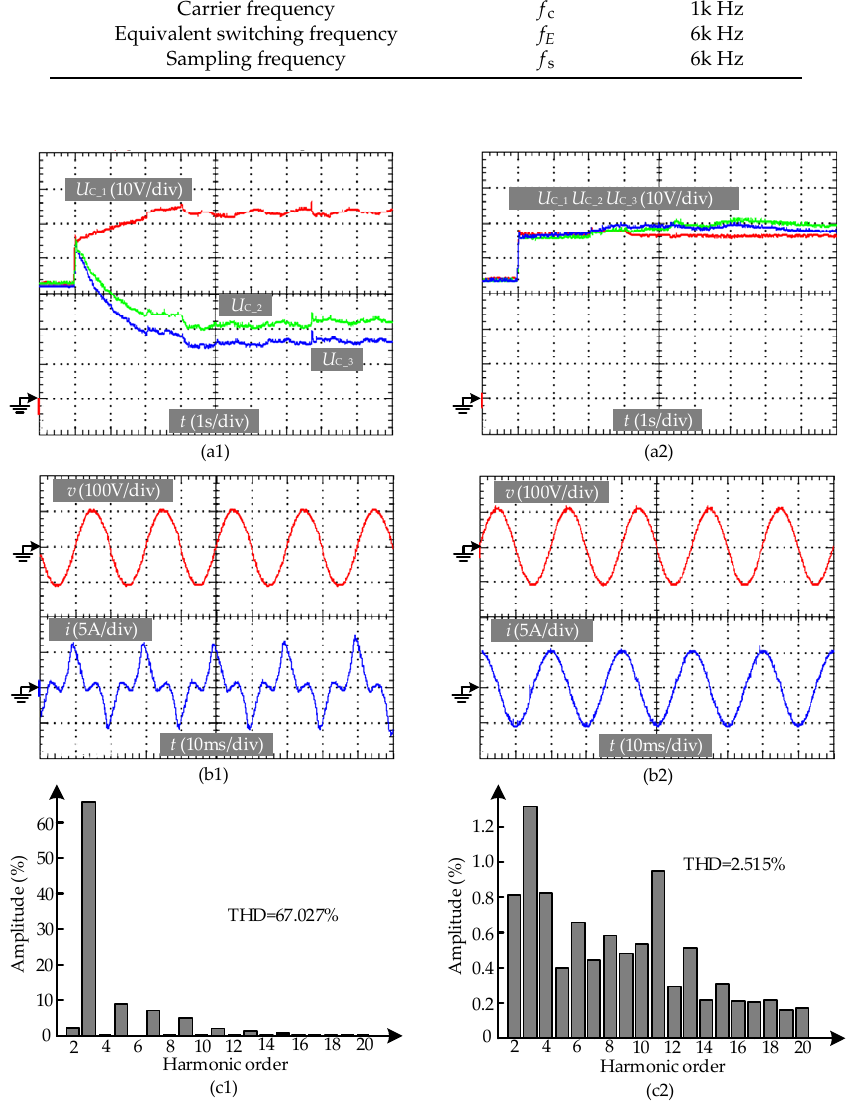
Figure 15. Experimental waveforms of the capacitor voltages, the grid voltage, and the compensating current, verifying the feasibility of the proposed CPSR-PWM, ( a1 ) and ( a2 ). Capacitor voltages with the conventional CPS- and the proposed CPSR-PWM schemes, ( b1 ) and ( b2 ). Grid voltage and compensating current with the conventional CPS- and the proposed CPSR-PWM schemes, ( c1 ) and ( c2 ). Fourier analysis of the compensating current with the conventional CPS- and the proposed CPSR-PWM